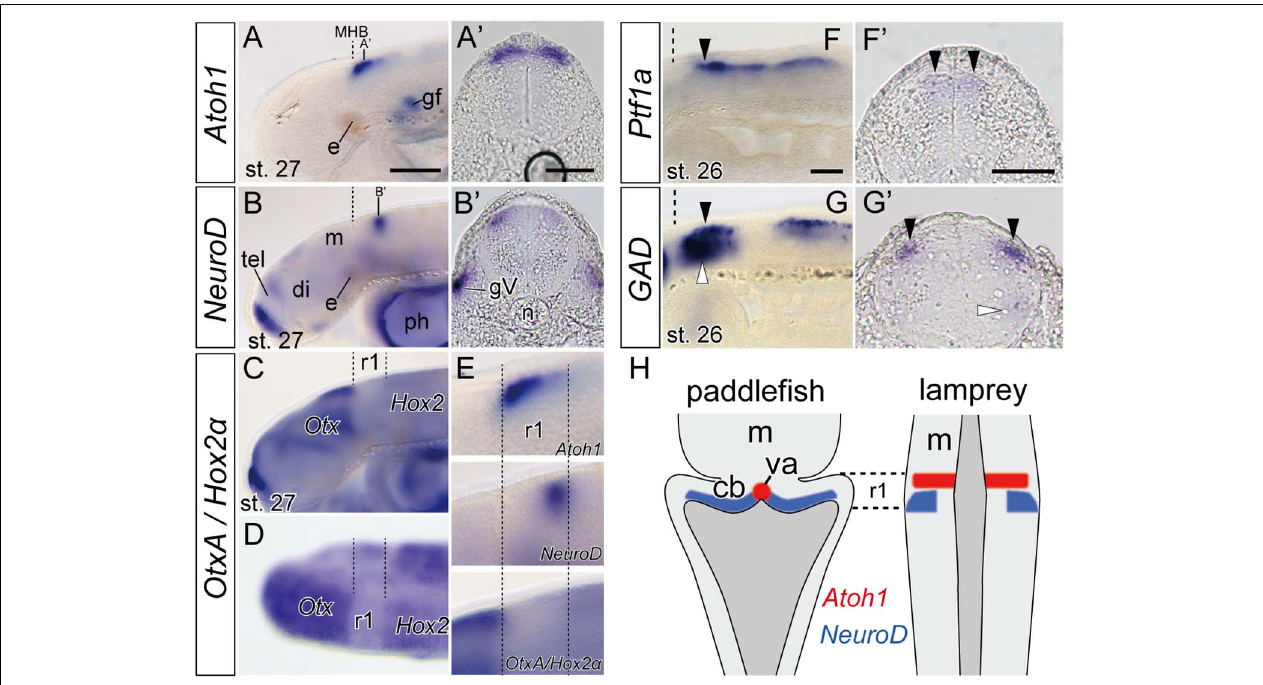
FIGURE 3 | Expression of genes involved in neuron differentiation during lamprey late embryonic stages. (A,A’) Atoh1 expression is restricted to the anterior r1 in stage 27 embryo (arrow heads). Dashed lines indicate the MHB. (B,B’) NeuroD expression is observed behind the Atoh1 expression domain (arrowheads). Note that (A’,B’) are not at the same rostrocaudal positions in r1. The apparent asymmetrical staining in (B’) does not reflect the actual difference in expression, but is caused by the slightly oblique cutting of the sections. (C,D) In situ hybridization of both OtxA and Hox2 α probes in stage 27 in lateral view (C) and dorsal view (D) . OtxA is expressed only anterior to the midbrain, whereas Hox2 α is expressed caudally from r2. Dashed lines indicate the borders of r1 identified as “Otx–Hox free” domain. (E) High magnifications of the panel (A–C) in r1 region. (F,F’) Ptf1a-B expression at the ventricular zone at stage 26 (arrowheads). (G,G’) GAD is expressed in the hindbrain at the same dorsal level than –but lateral to– the Ptf1a expression domains (black arrowheads) and also in a ventral domain (white arrowheads). (H) Comparison of Atoh1 and NeuroD expression patterns in the hindbrain between paddlefish, Polyodon spathula (stage 42, based on Butts et al., 2014c), and lamprey. Note that although the lamprey hindbrain does not show a ‘diamond shape’ of the rhombic lip during embryonic stages, the topological relationship of these gene expression patterns is comparable in both species. cb, cerebellum primordium; gV, trigeminal ganglion; ph, pharynx; va, valvula cerebelli. See Figures 1 , 2 for other abbreviations. Scale bars, 100 µ m (A–D) , 50 µ m (A’,B’,F,F’,G,G’)